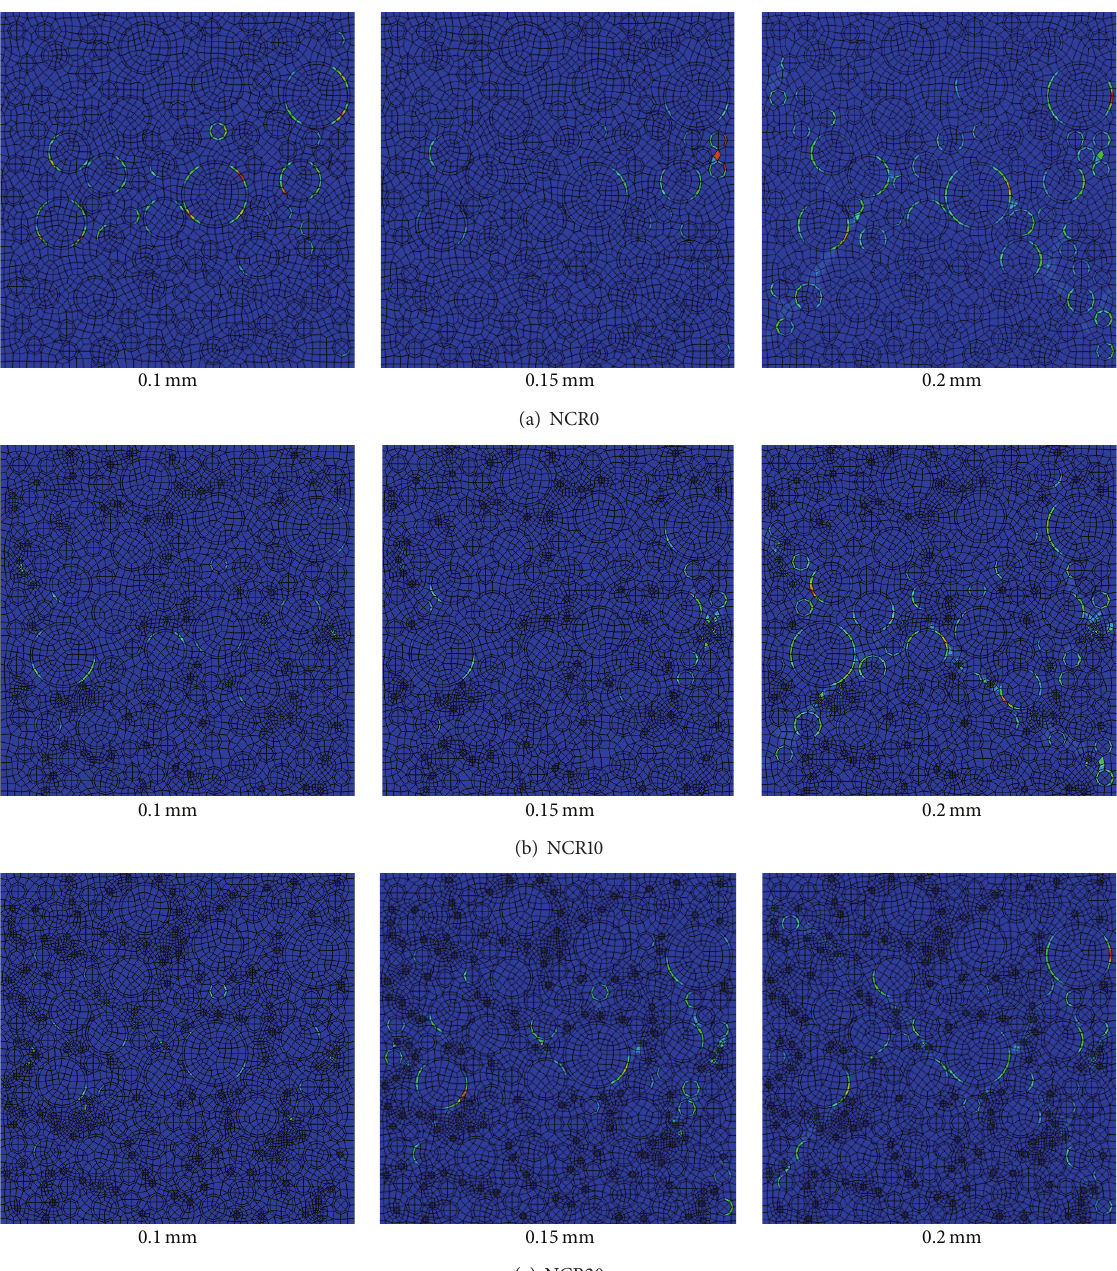
Figure 9: Fracture distribution in rubber concrete, taking into account the bonding